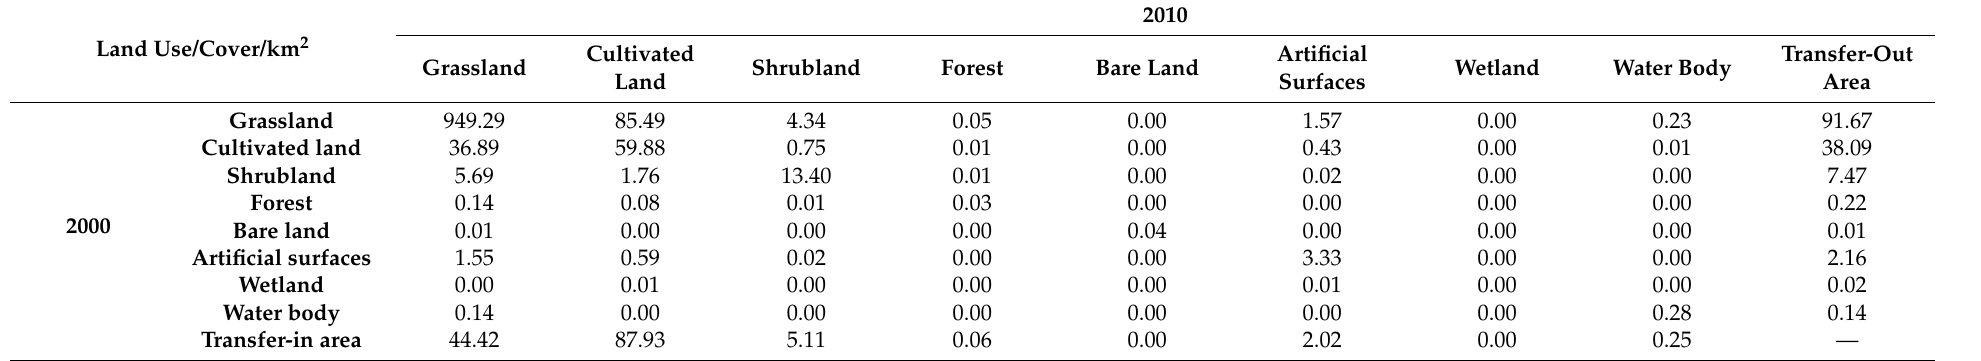
Table 2. Land use/cover conversion matrix of alluvial fans from 2000 to 2010.